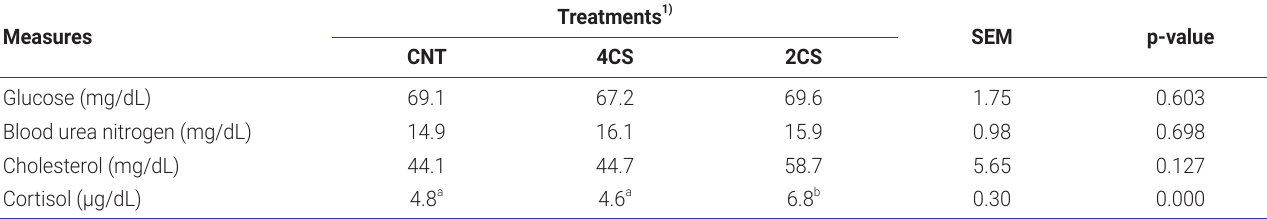
Table 5. Blood metabolites measures of Holstein Friesian cows under different treatments during summer (n = 21)